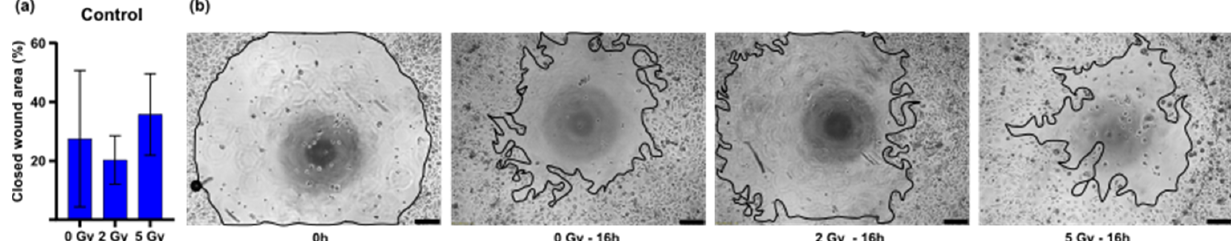
Figure 3. Keratinocyte migration of the irradiated control groups without growth factor treatment: ( a ) Y-axis shows closed wound area at time point 16 h after 0, 2, 5 Gy irradiation; ( b ) representative images of irradiated keratinocytes at time point 0 h and 16 h. Scale bar 200 µm.